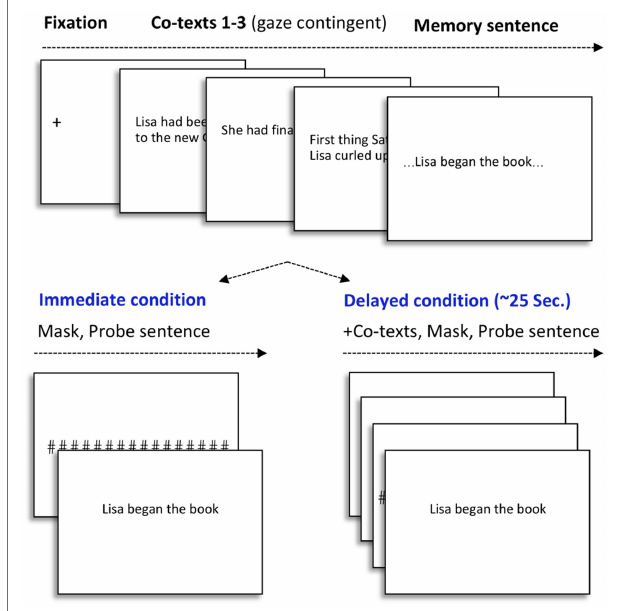
FIGURE 1 | Schematic representation of each trial. Top row represents the presentation of the context, with the last screen representing the indeterminate sentence. The trial continues in one of two conditions, represented in the bottom row, either with an immediate presentation (0 s) of one of the three probe sentences, or, in the delayed condition (+25 s), with a neutral context, followed by one of the probe